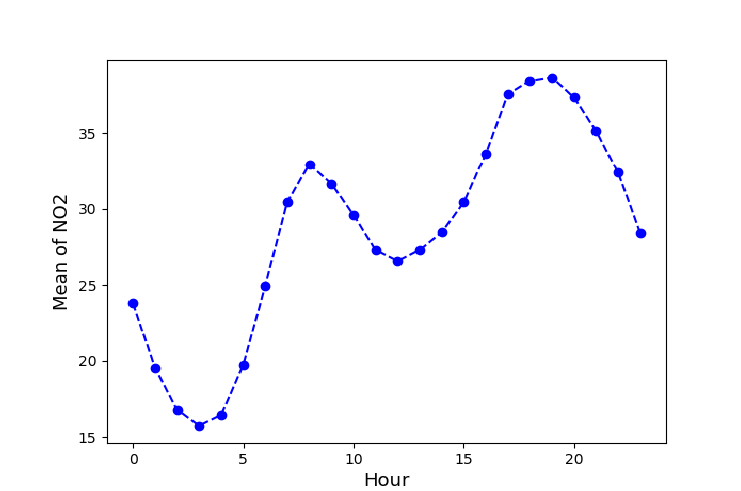
Figure 11. Mean hourly NO 2 concentrations from Blanchardstown air quality monitoring station. Software: Python [57].